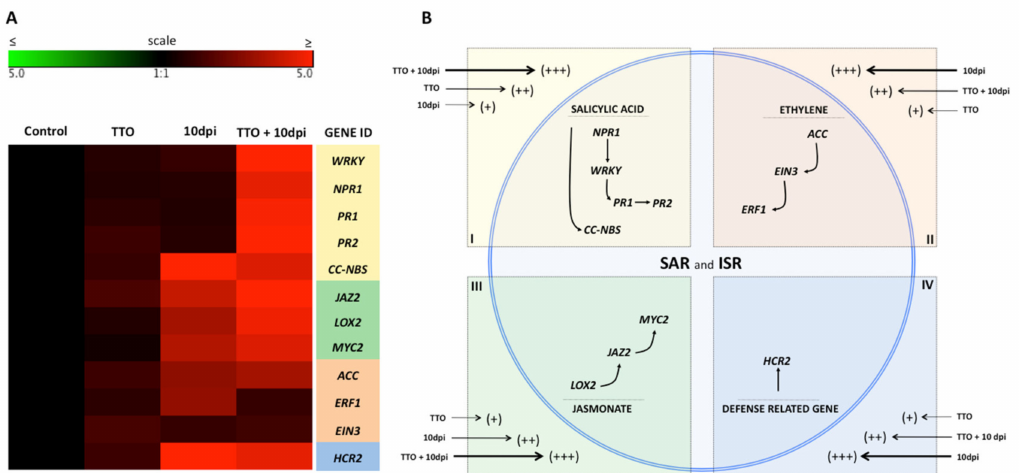
Figure 6. TTO induces systemic resistance to bacterial spot in tomato plants via SAR and ISR pathways. ( A )—Gene expression in tomato plants infected by X. campestris . The heat map illustrates the doubled changes in gene expression (log2 scale) in samples collected 10 days after application of TTO (TTO); 10 days postinoculation X. campestris (10dpi); and 10 days after application of TTO more postinoculation X. campestris (TTO + 10dpi). Di ff erent shades represent induced or repressed gene expression. Biological and technical triplicates were used in the analysis. Gene acronyms are listed in the right column. The defense routes are indicated by colors according to the legend. ( B )—Scheme illustrating regulation of salicylic acid, ethylene and jasmonate in the plant cell. Arrow sizes and scores ( +++ ; ++ ; + ) indicate the intensity of expression of genes related to SAR and ISR